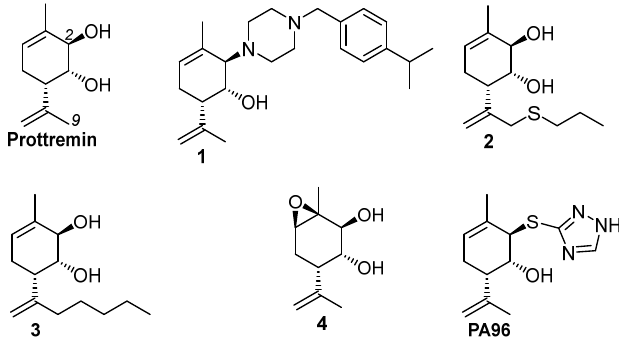
Figure 1. Prottremin and its derivatives.